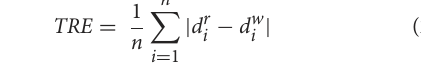
importance, availability in public datasets, and relative simplicity of